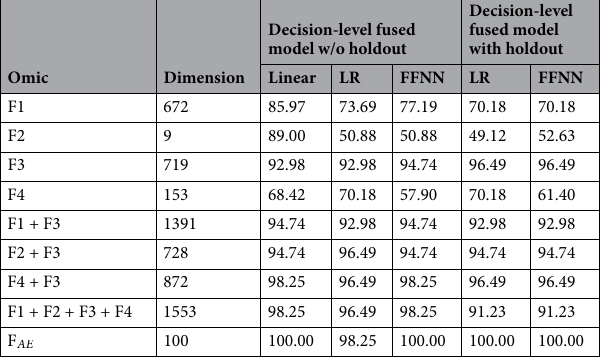
Table 2. Summarizing the test accuracy from different classifier combination techniques for different levels of evidence (F1: mRNA (PcGs) expression, F2: miRNA expression, F3: DNA methylation, F4: protein expression, F AE : features from bottleneck layer of autoencoder, LR: logistic regression, FFNN: feed-forward neural